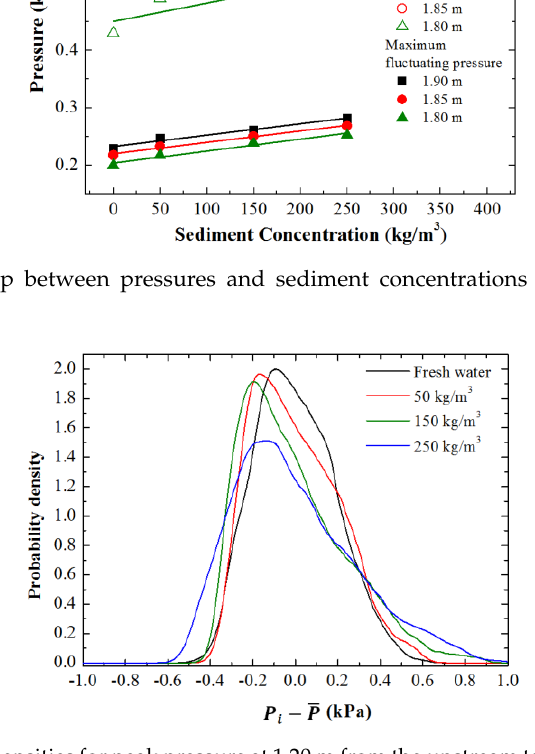
Figure 10. Probability densities for peak pressure at 1.20 m from the upstream tank at different sediment concentrations and an upstream water head of 1.90 m.